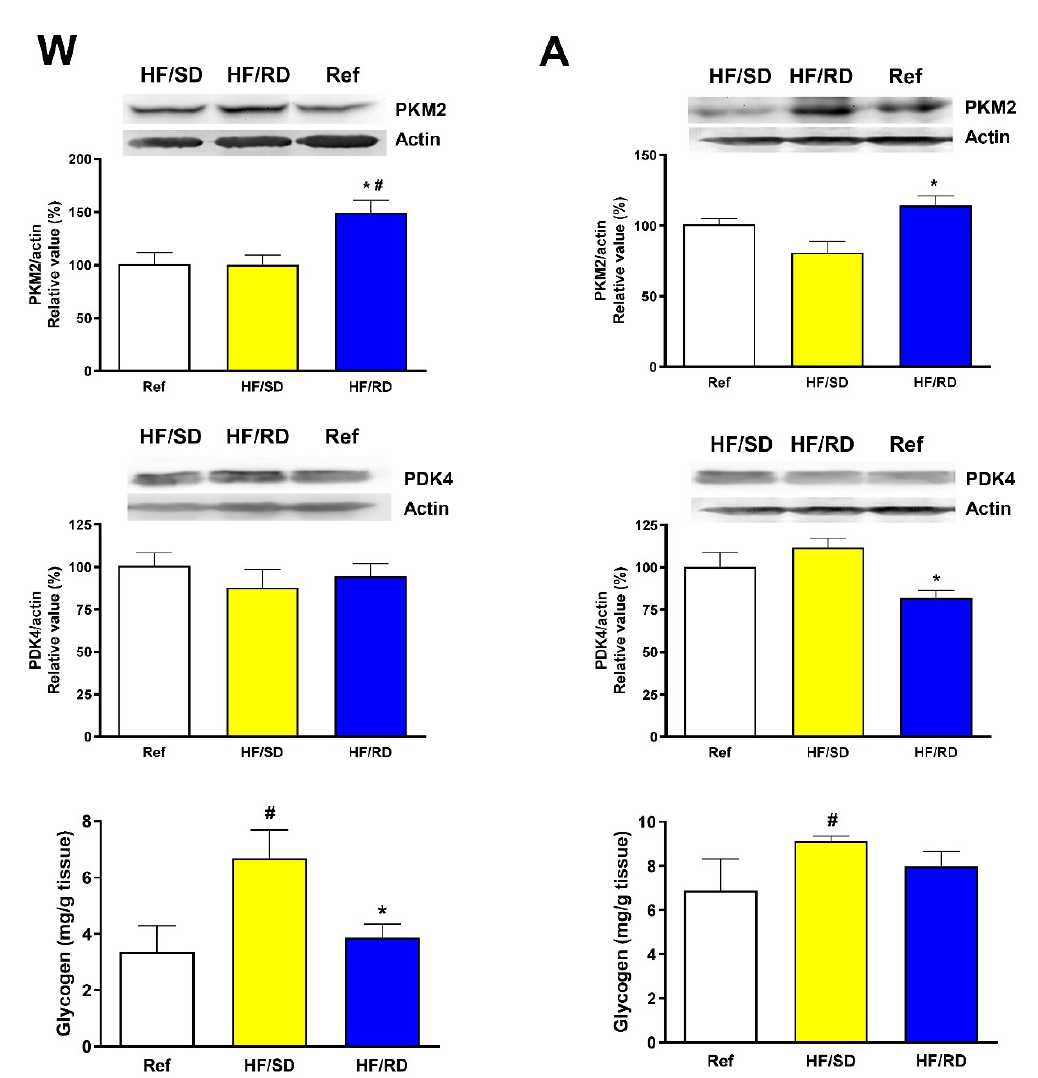
Figure 4. Muscle Pyruvate kinase isoenzyme M2 (PKM2) and Pyruvate Dehydrogenase Kinase 4 (PDK4) expression and glycogen content. PKM2 and PDK4 expression was assayed by Western blot in gastrocnemius muscle at weaning ( W ) and adolescence ( A ). Glycogen content was measured as described in the Methods Section. Values are means ± SEM ( n = 8 for each experimental group). HF/SD: offspring from mothers on high-fat diet containing slow digesting carbohydrates; HF/RD: offspring from mothers on high-fat diet containing rapid digesting carbohydrates; Ref: offspring from mothers on AIN93G diet. * Significant difference with HF/SD group, p < 0.05. # Significant difference with reference group, p < 0.05.